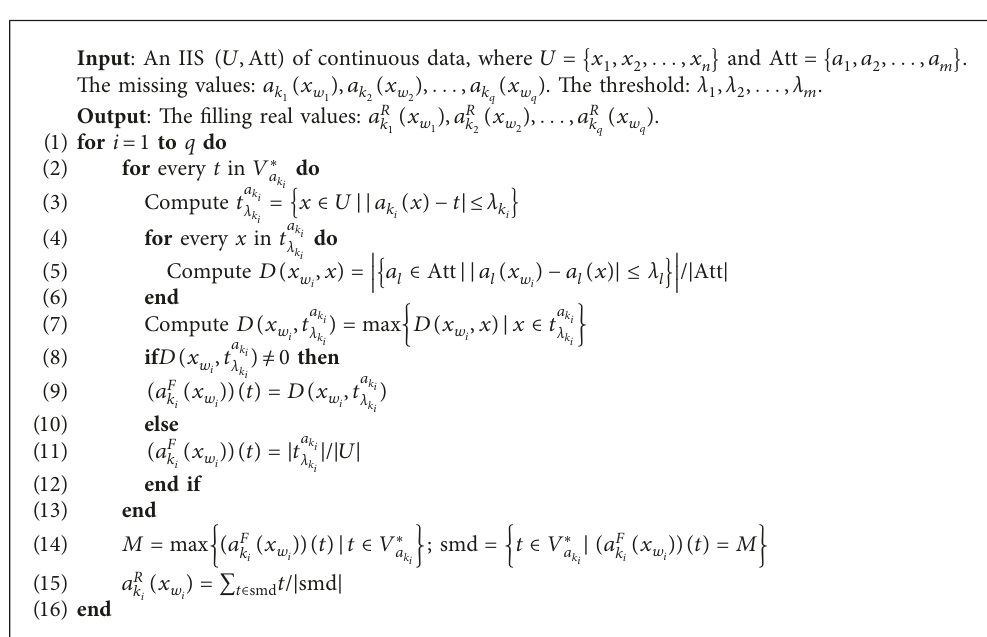
A LGORITHM 4: Algorithm FMvRV: filling the missing values with real values.